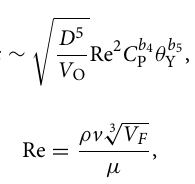
From the theoretical aspect, when the other parameters are fixed, Eq. (3) reduces to F ~ D −2 . It is seen that, the values of − 2.23 and − 2 are very close, which indicates the experimental result is reliable. Magnetic foam moving process. In the experiment, the snapshots of the magnetic foam at three stages are recorded, i.e. onset, interplay with oil droplet, and movement by carrying oils, which are shown in Fig. 4. Firstly, the end of the foam near the magnet is activated to move owing to the force of the magnetic field, with the distance D = 10 mm. Then under the action of the magnetic field, the foam is accelerated forward. When the elapsed time t = 3 s, the surfactant in the foam interacts with the oil droplet. As a result, the surface tension of the oil droplet in the acting part is suddenly reduced, and then the oil droplet cannot maintain the original stable state and become collapsed. When the time t = 6 s, more foams wrap the oil droplet to facilitate the emulsification of oil droplet. Next, when t = 8 s, the foam gradually emulsifies the oil droplet, and the oil droplet becomes one part of the whole foam–oil system. After that, the magnetic foam continues to move by carrying the oil under the magnetic force. During the moving process of the foam, due to the adhesion force between the oil droplets and the substrate, the resistance of the foam–oil system gradually increases. When the time t = 12 s, the foam stops moving attrib- uted to the resistance. Besides the adhesion between the oil and the substrate hindering the foam, it is observed that with the interaction between the surfactant in the foam and the oil film, some bubbles inside the foam may lose water and burst. It is also noticed that, part of the magnetic particles fall on the bottom of the foam under the influence of gravity. As a result, the regulating ability of the magnetic particles on the foam is greatly weakened, and finally the foam stops moving as the resistance of the substrate is bigger than the driving force of the magnetic field.